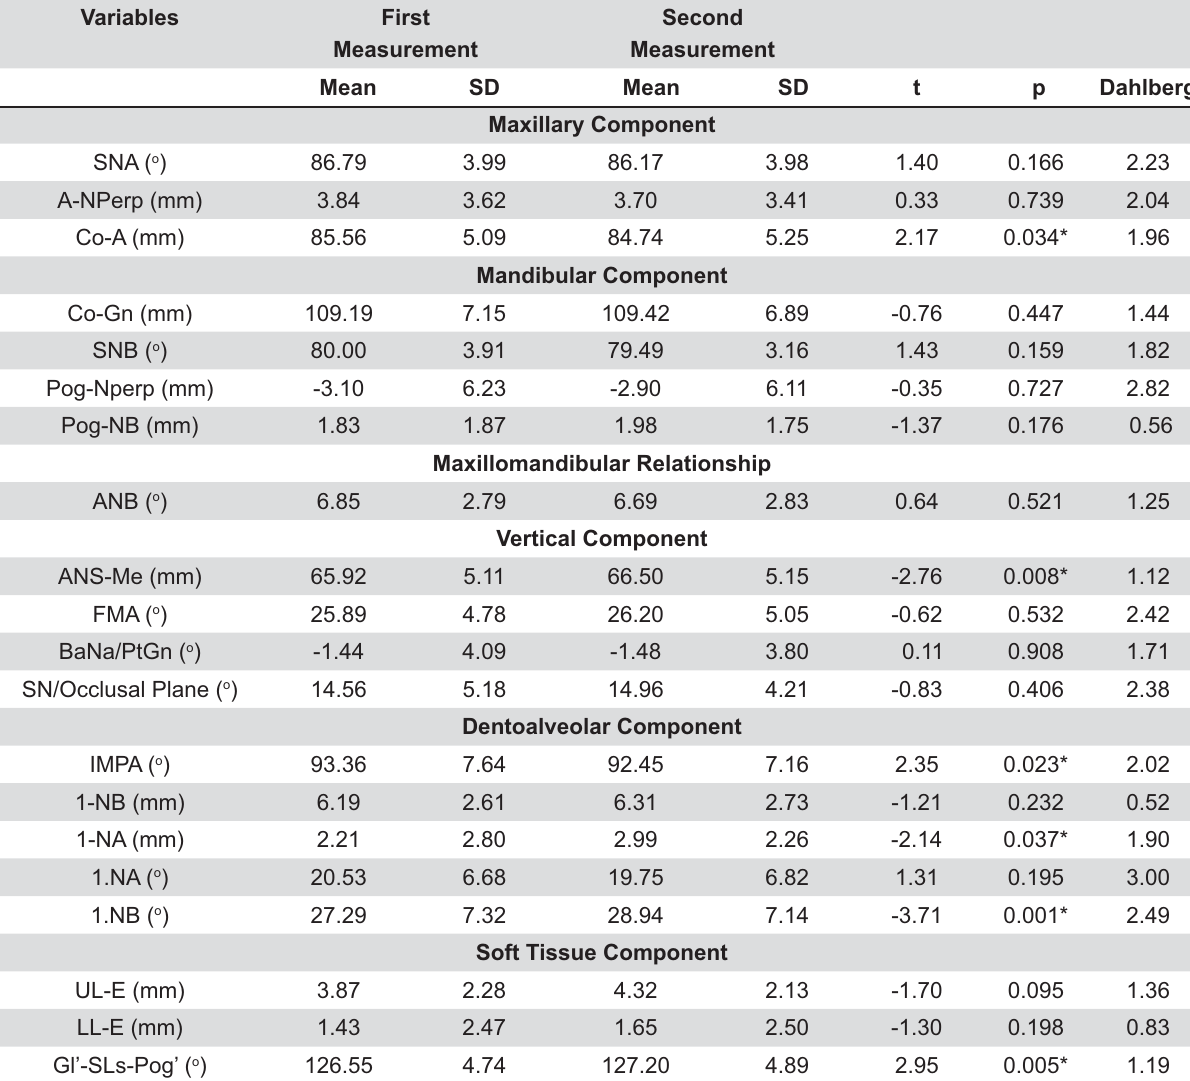
Table 2- Results of systematic and casual errors investigation for digitized lateral